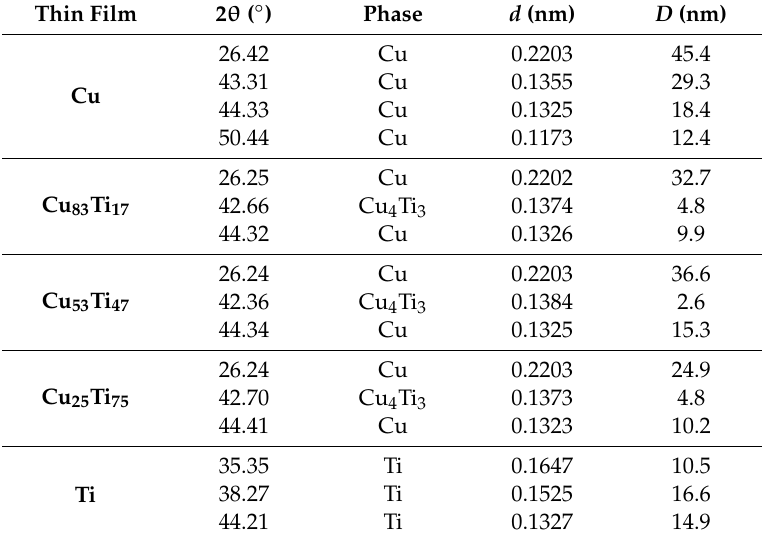
Figure 3. XRD patterns of prepared coatings: ( a ) Cu, ( b ) Cu 83 Ti 17 , ( c ) Cu 53 Ti 47 , ( d ) Cu 25 Ti 75 , and ( e ) Ti. Table 2. Structural parameters of thin films based on Cu and Ti, determined by XRD.